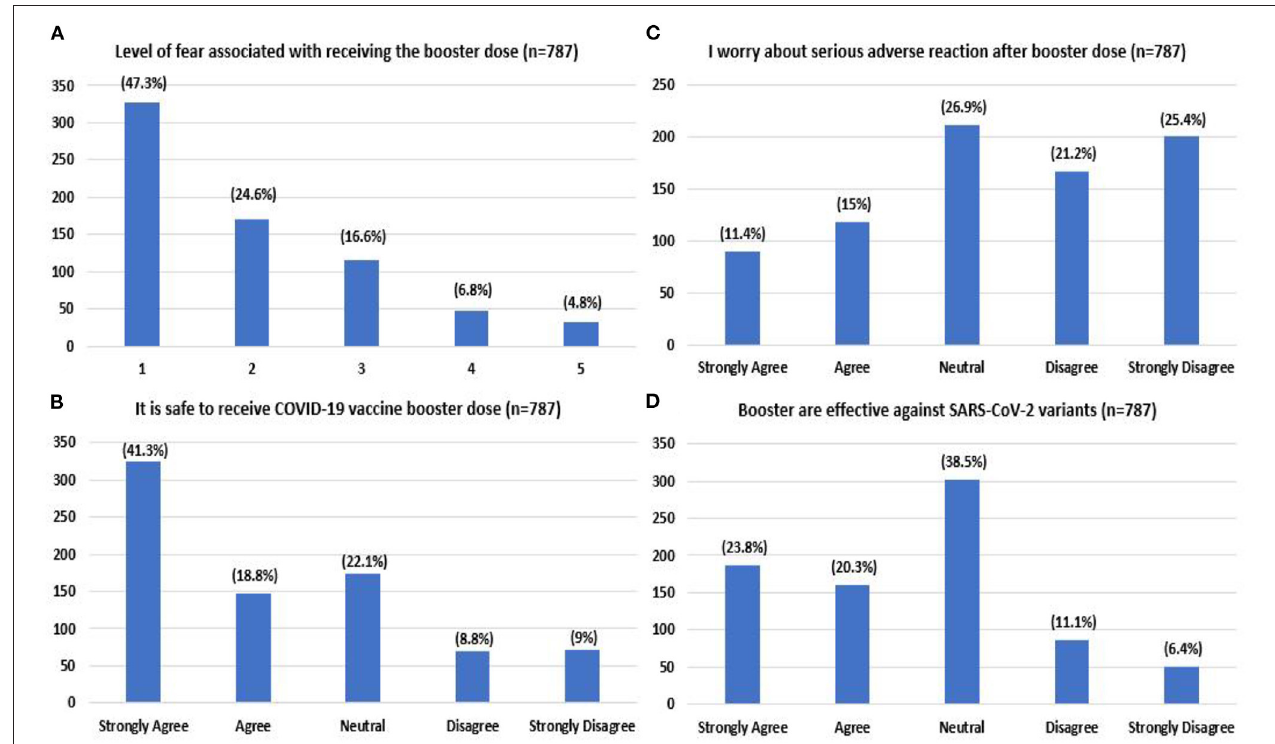
FIGURE 3 | Level of fear associated with booster dose (A) (1- no/very low fear, 5- very high fear) attitude toward booster dose regarding level of safety (B) , worry (C) , and effectiveness (D) reported by the study participants.